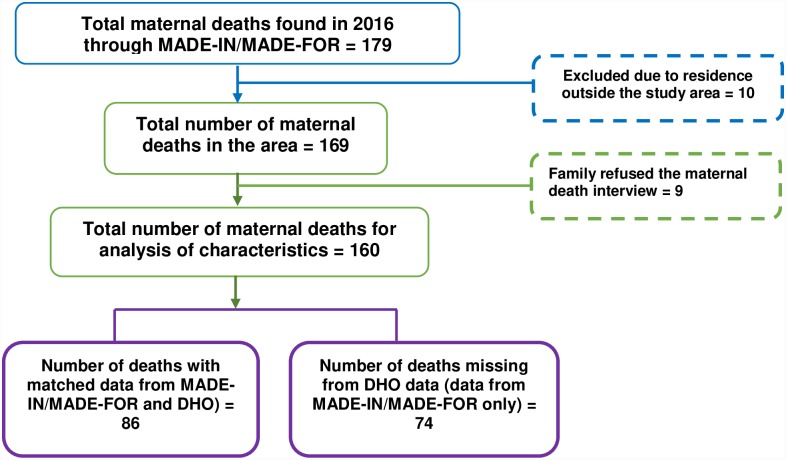
Case identification.